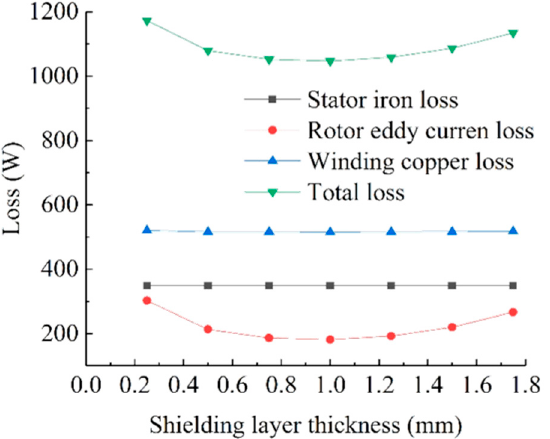
Figure 17. Comparison diagram of motor loss with different shielding-layer thicknesses at 20 °C.